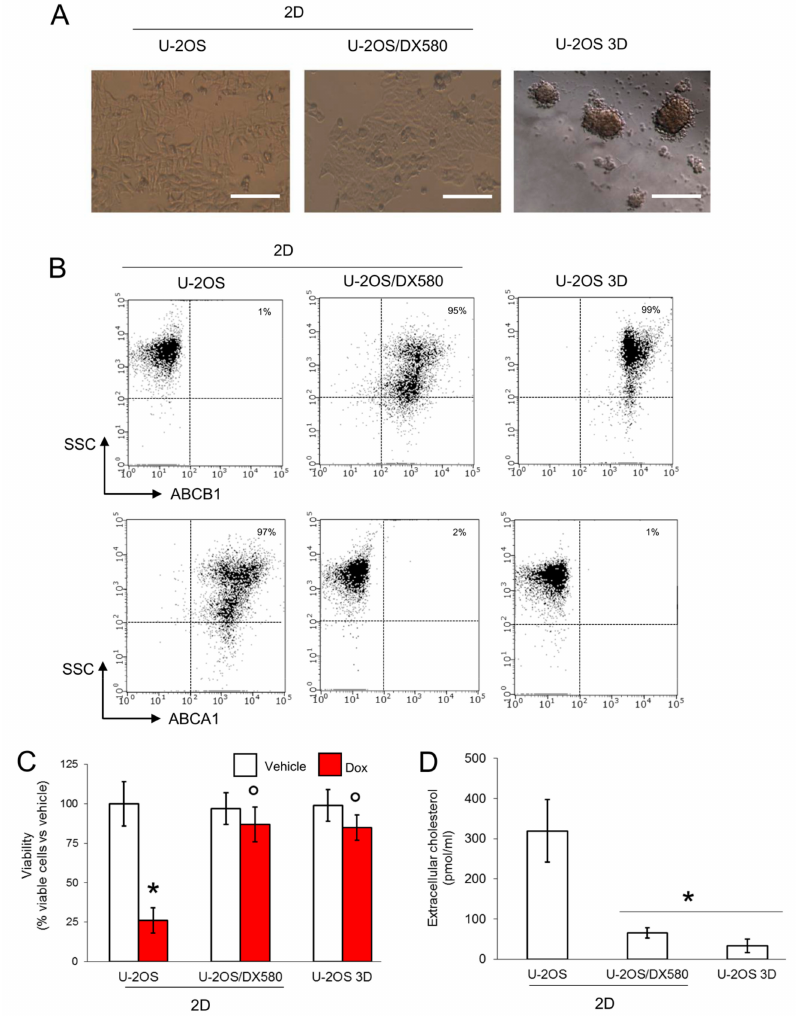
Figure 1. 3D cultures of U-2OS cells display an ABCB1 high ABCA1 low phenotype. ( A ) Representative micro-photographs of U-2OS cells, U-2OS / DX580 cells, both grown as 2D cultures, and U-2OS cells grown in 3D culture (10 × ocular lens, 4 × objective). Bar: 100 µ M. ( B ) Dot plots of ABCB1 and ABCA1 proteins on the cell surface, measured by flow cytometry in duplicates. The figure is representative of one out of three experiments. SSC: side scattering. Percentage of ABCB1- and ABCA1-positive cells, calculated as cells with a fluorescence > 10 2 using the Incyte